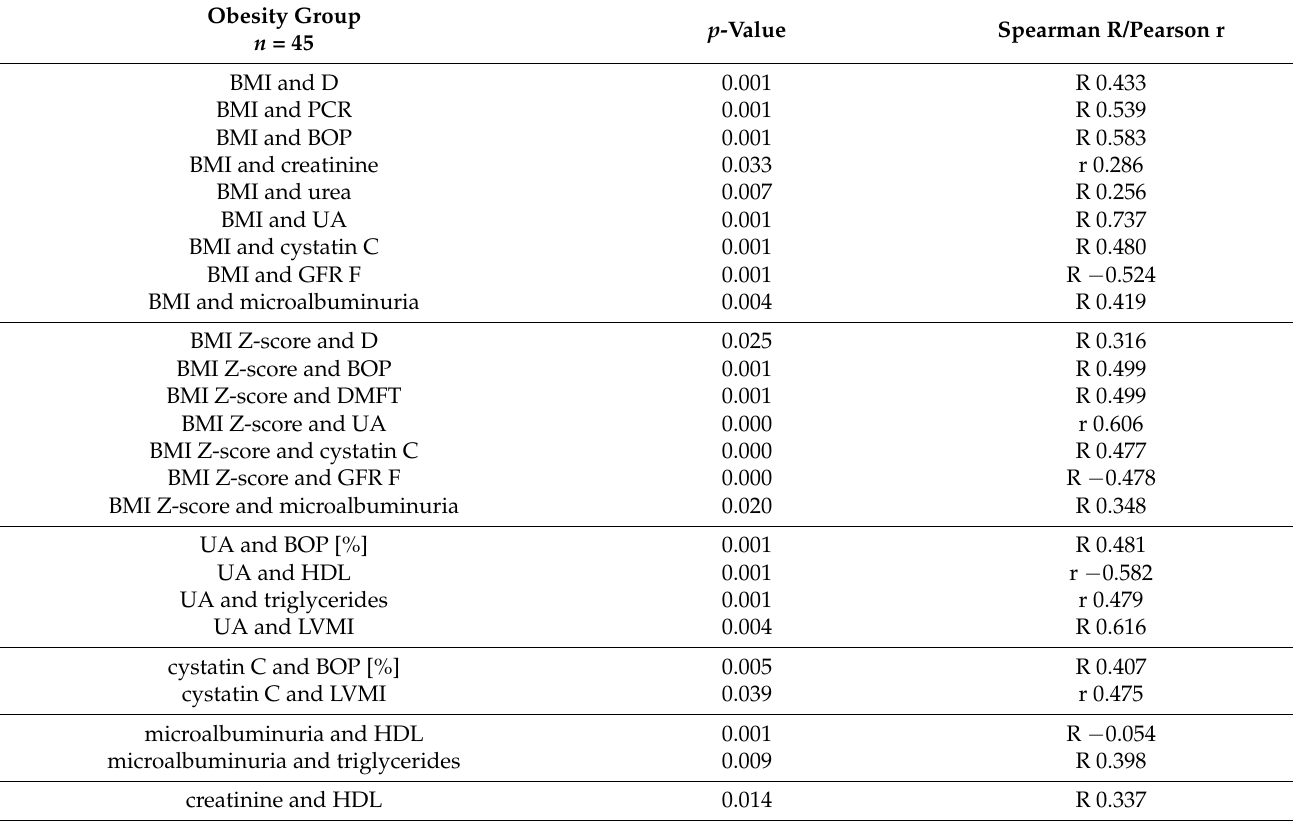
Table 3. Significant results of the Spearman’s and Pearson’s correlation rank tests regarding clinical and biochemical parameters ( p < 0.05) for the obesity